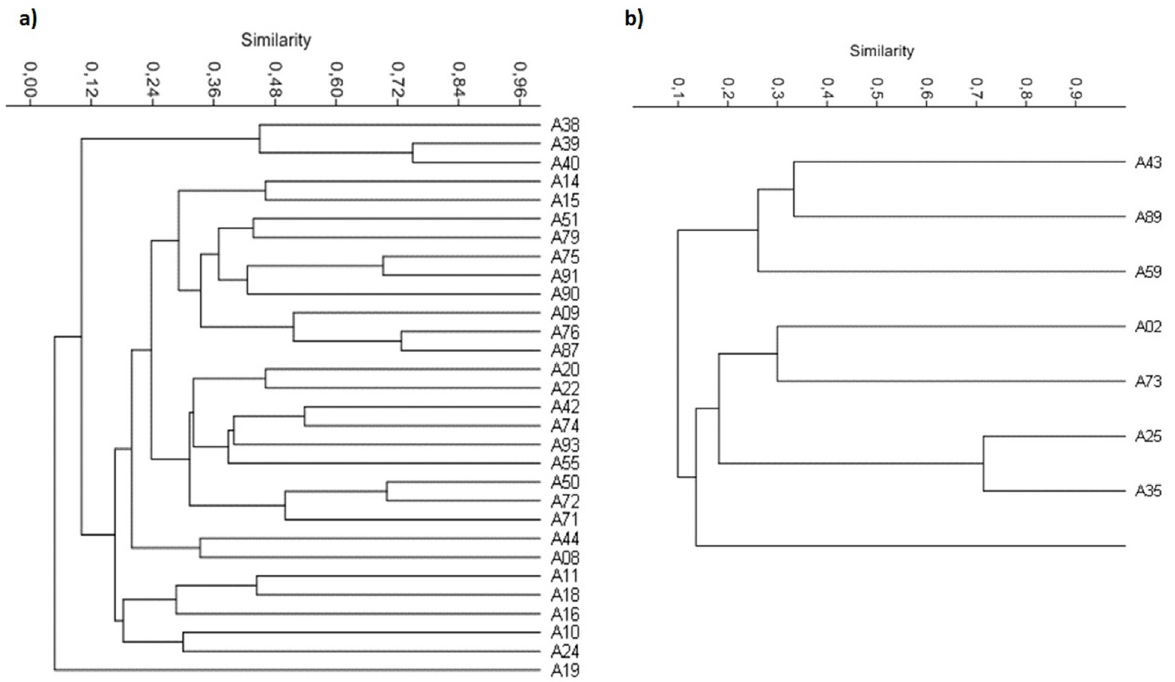
Figure 5. Dendrogram representing the patterns of Enterobacterial Repetitive Intergenic Consensus (ERIC-PCR) from Acinetobacter spp. clinical isolates in Recife – PE – Brazil. a) Acinetobacter baumannii isolates and b) Acinetobacter calcoaceticus-baumannii complex